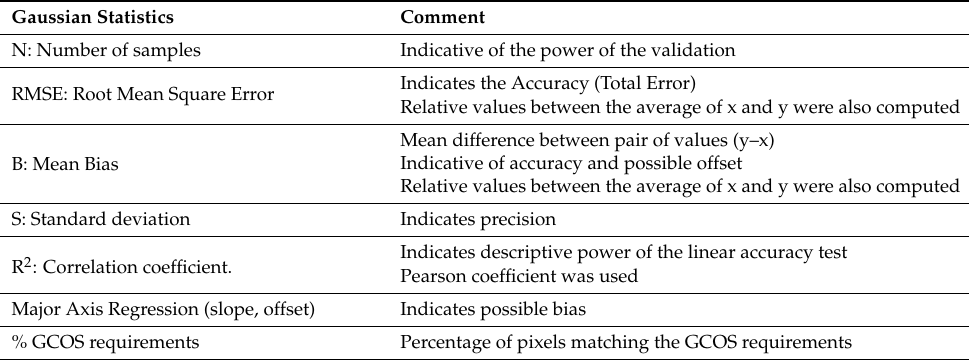
Table 5. Uncertainty metrics for product